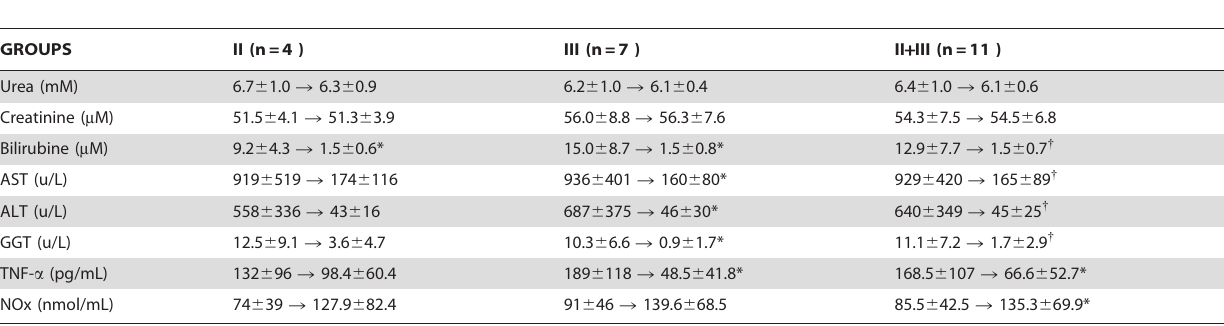
Table 2. Variations in renal and liver function tests and serum TNF- a and NOx levels in surviving cirrhotic rats between the infection of E.coli and the